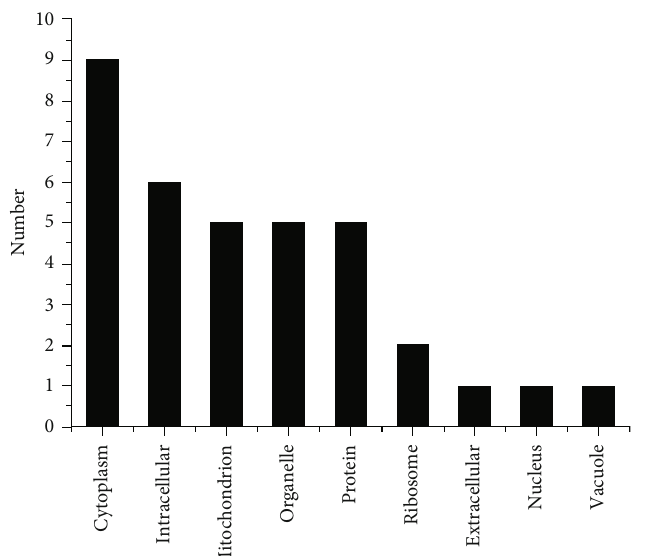
Figure 2: The cellular localization of di ff erences protein of Coriolus versicolor in response to methanol extracts from the xylem of Cinnamomum